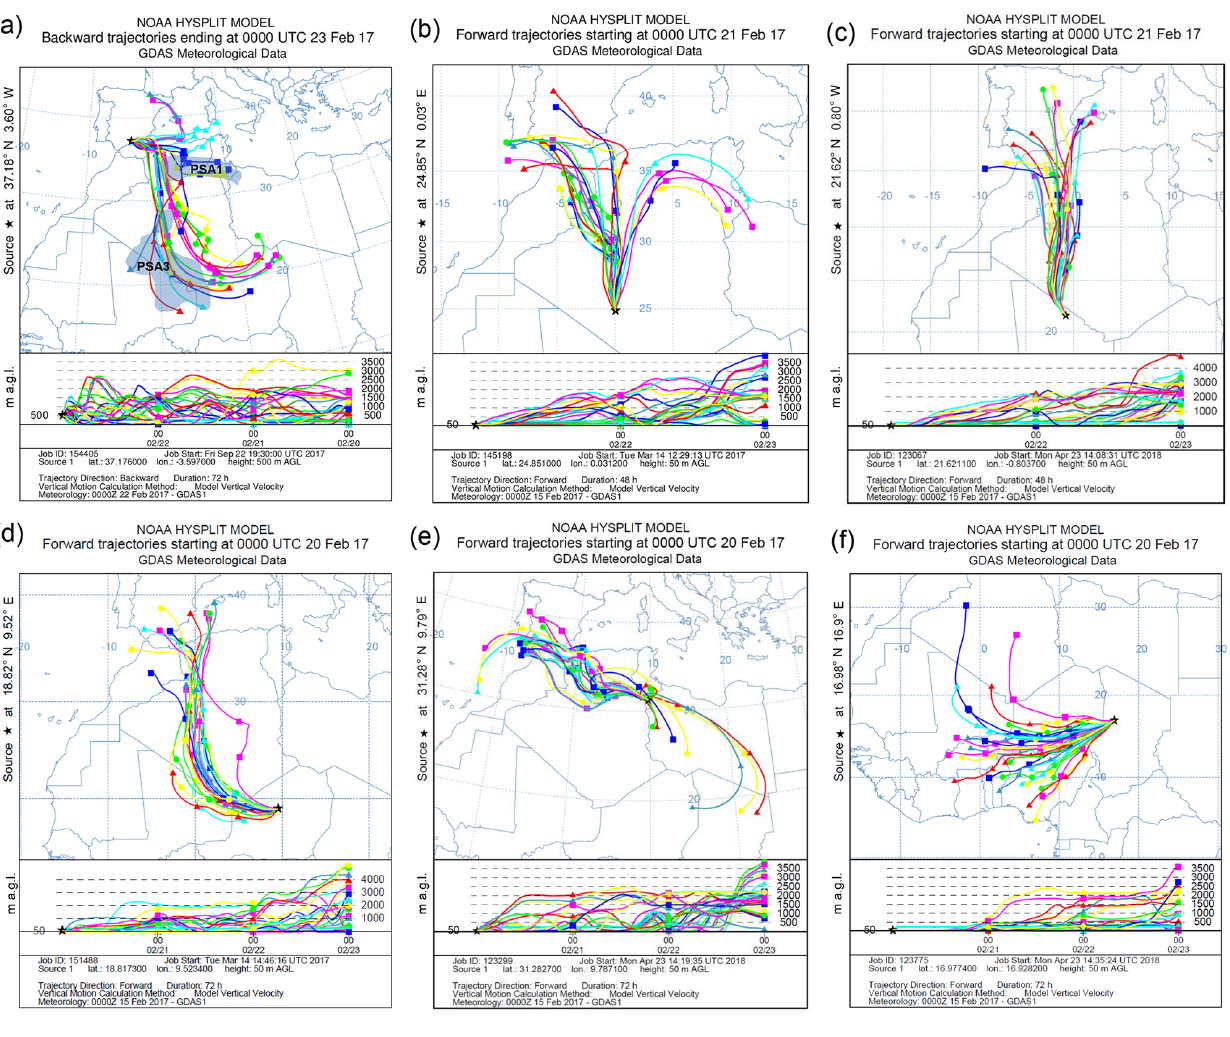
Figure 4. Results of NOAA’s HYSPLIT modeling of (a) 72h multiple (25) back-trajectories for air masses arriving at Granada on 23 February 2017 (00:00UTC) and (b–f) forward multiple (25) trajectories for selected dust source areas. Shaded areas in (a) show potential source areas PSA1 and